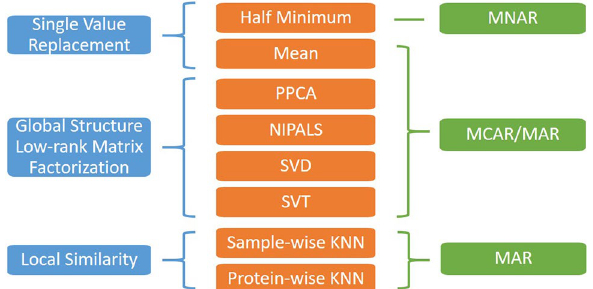
Figure 1. Comparative assessment of eight representative missing value imputation methods, divided into three